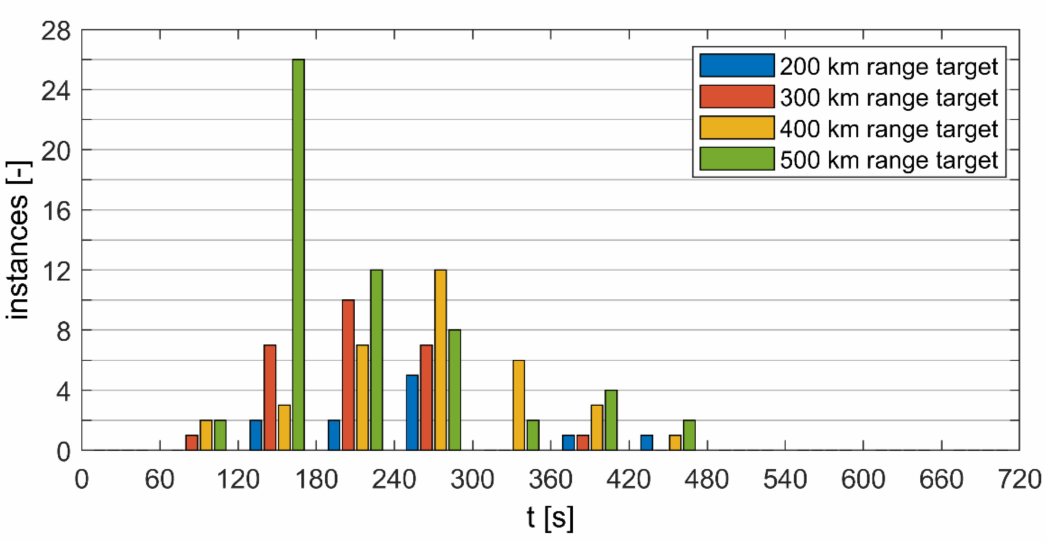
Figure 12. REX engagement instances binned by engagement time for CLTC-P and vehicle mass of 1500 kg.